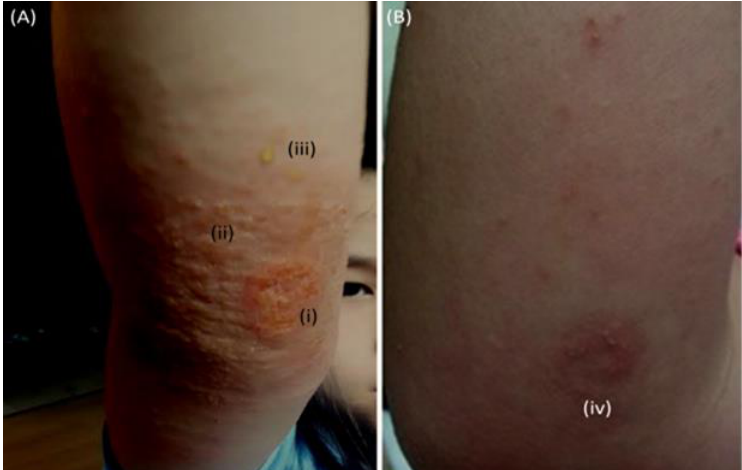
Figure 2. Photograph of SA-infected abrasion (patient X (Age 9-female); 4 October 2016) following administration (1 October 2016) of low-dose erythromycin and corticosteroids ( A ). Permanganate (aq) cleansing, followed by administration of high-strength oral antibiotics (amoxicillin) (5 October 2016); overnight resolution of non-localized symptoms (neck, head, and trunk) highest recorded patient temperature 38.5 °C. Day 30 barrier restored ( B ). (i) Infected area, (ii) immunological reaction to SA toxins, (iii) honey-colored fluid, (iv) skin repaired, sporadic folliculitis. Modified with permission from Springer [63].